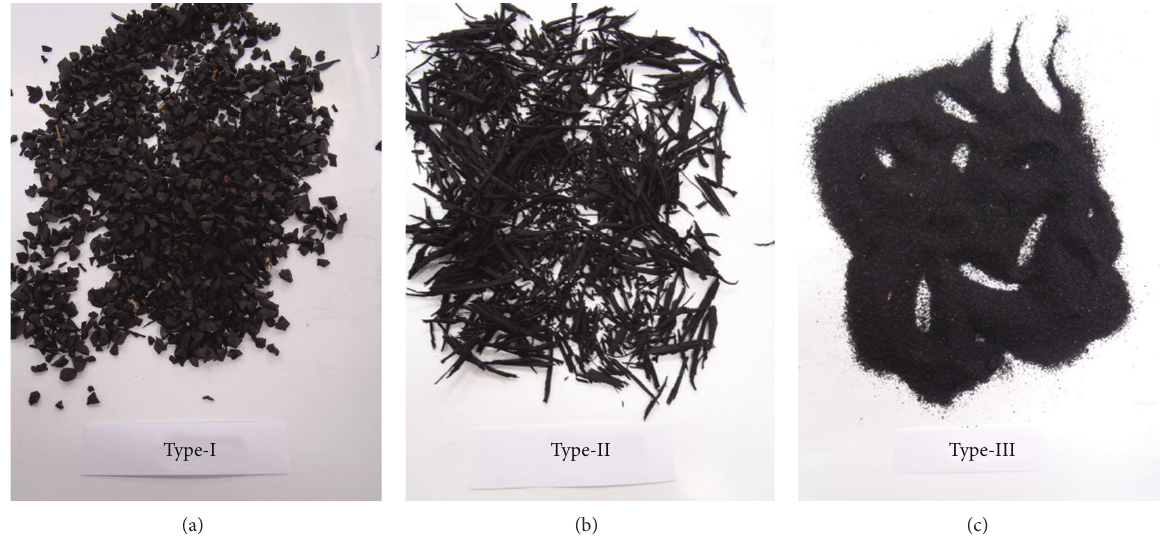
Figure 2: Tire rubber after the shredding and grinding: (a) Type-I, (b) Type-II, and (c) Type-III process.